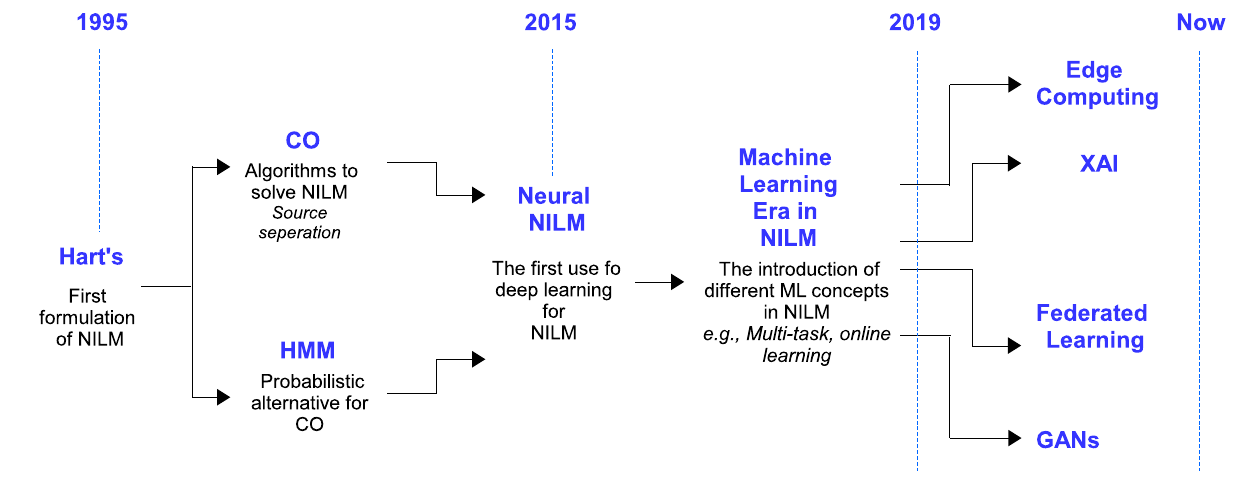
Figure 3. Historical development of